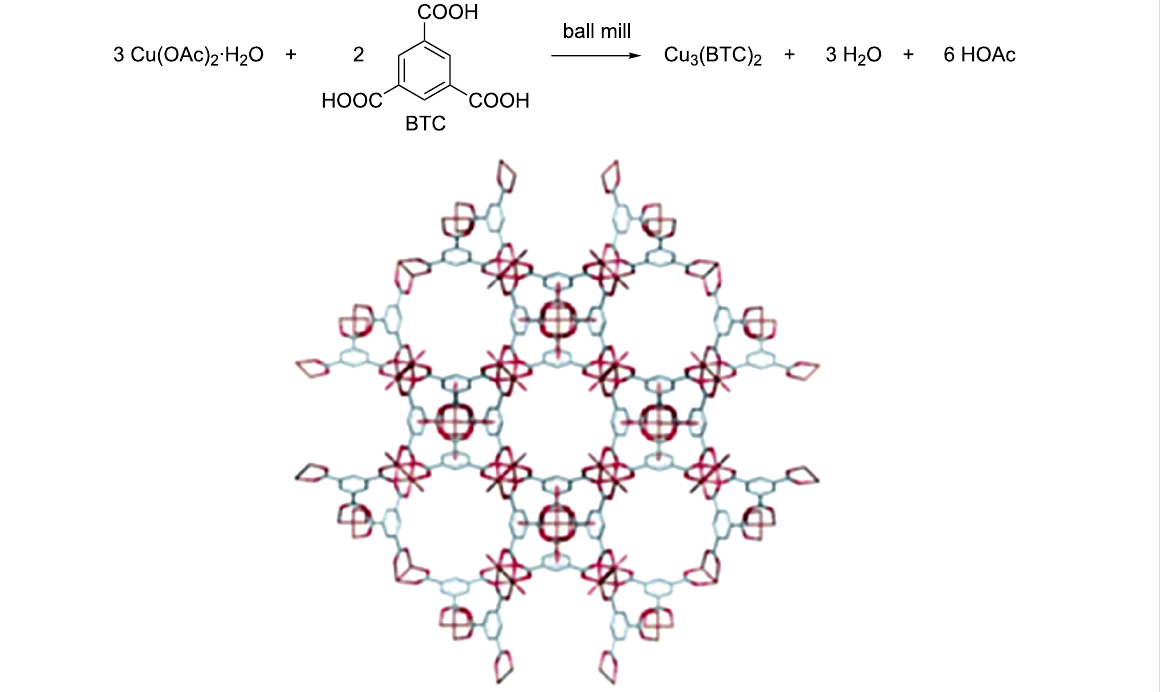
Figure 3: Mechanochemical reaction to form Cu 3 (BTC) 2 and the structure of Cu 3 (BTC) 2 ·(HKUST-1) as reported by Williams et al. [132]. Reprinted with permission from [131], copyright 2010 the Royal Society of